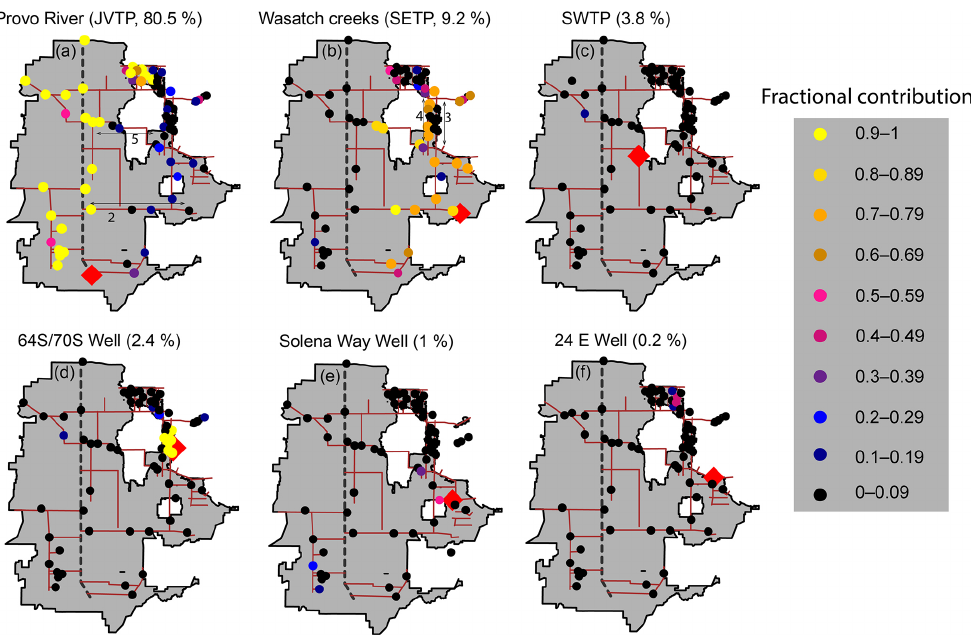
Figure 5. Mean of the posterior contribution of selected sources at the distribution sites for June 2015. Distribution sites are shown as circles and the color reflects the mean of the posterior contribution from the respective source at that site. The source in each panel is shown as a red diamond. The name of the source and its percent volumetric contribution ( V ) is shown above each panel. Transmission lines 2 and 5 are shown in (a) and lines 3 and 4 are shown in (b)